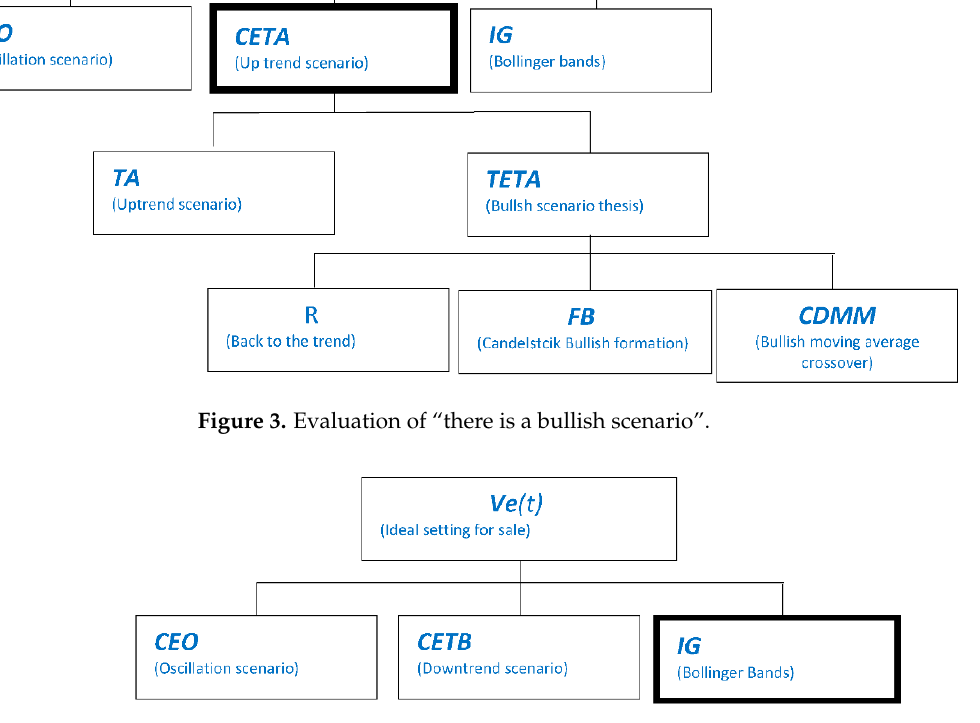
Figure 4. Evaluation of “Bollinger bands indicate that the financial asset should be bought”.